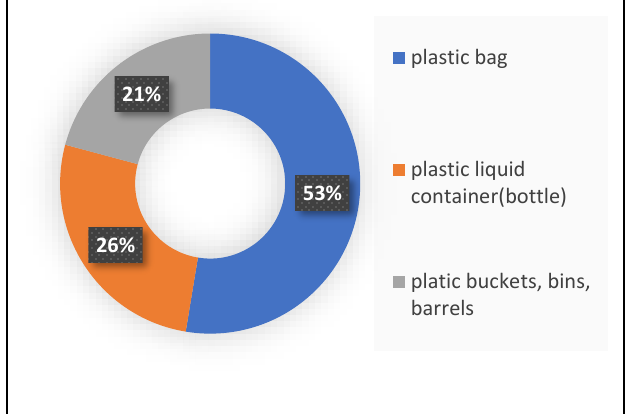
Fig. 5. The usage of plastic